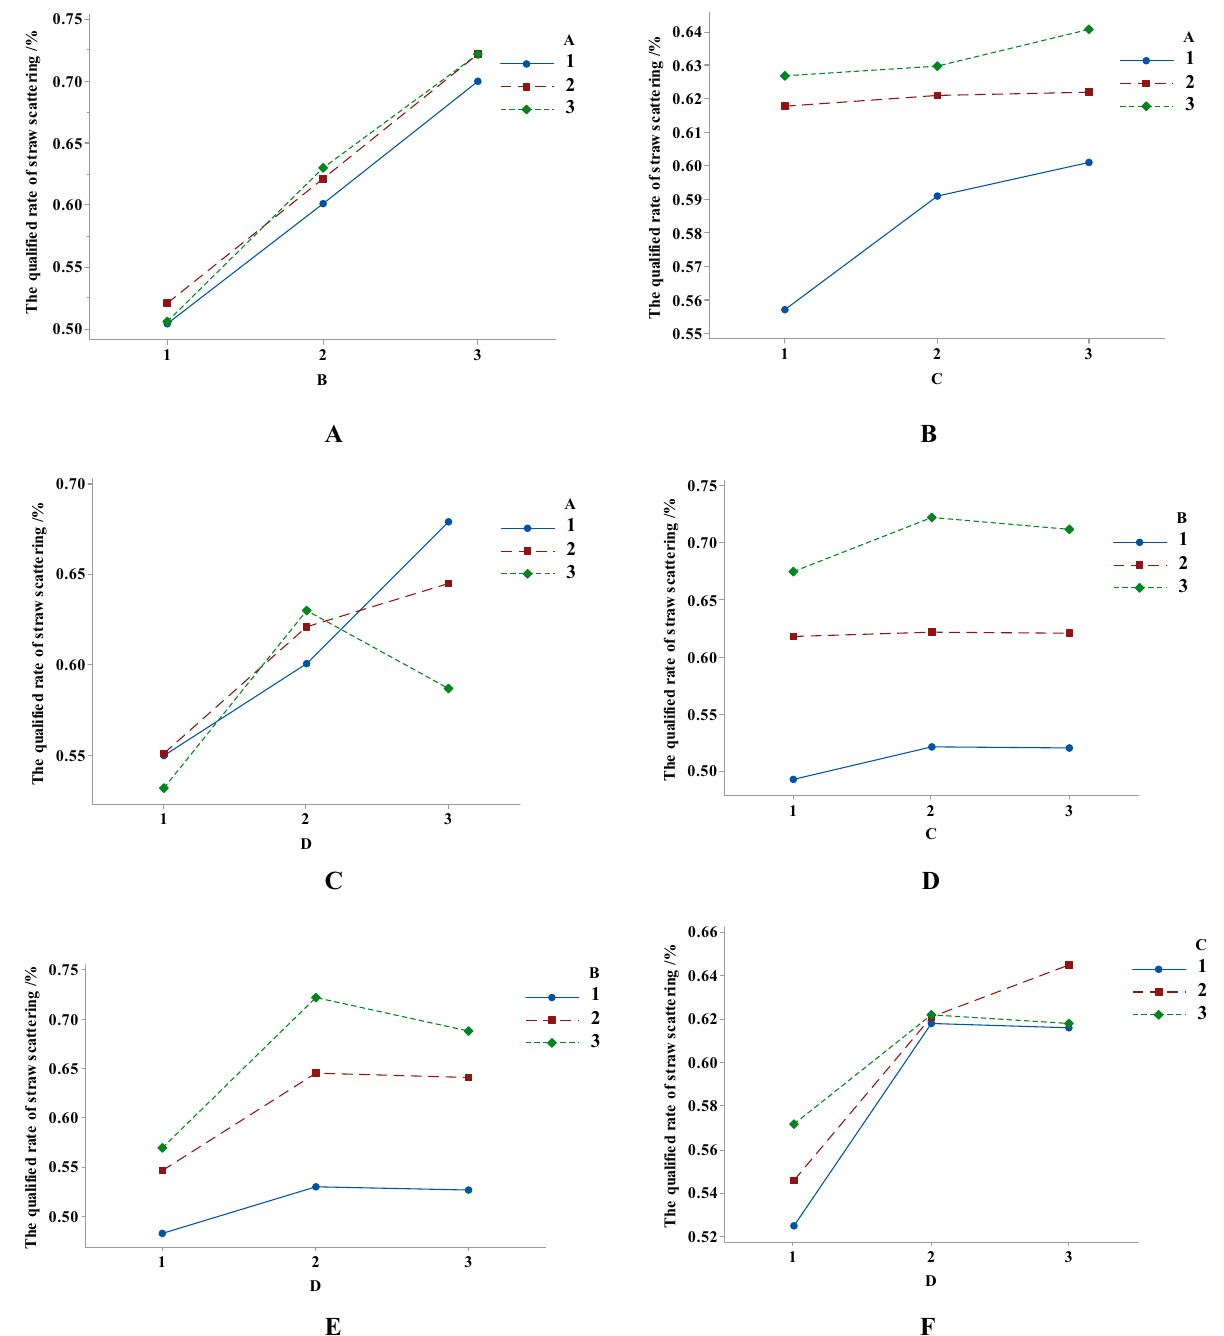
Figure 9. Simulation test results of interactive discriminant between factors. ( A ) A and B , ( B ) A and C , ( C ) A and D , ( D ) B and C , ( E ) B and D , ( F ) C and D